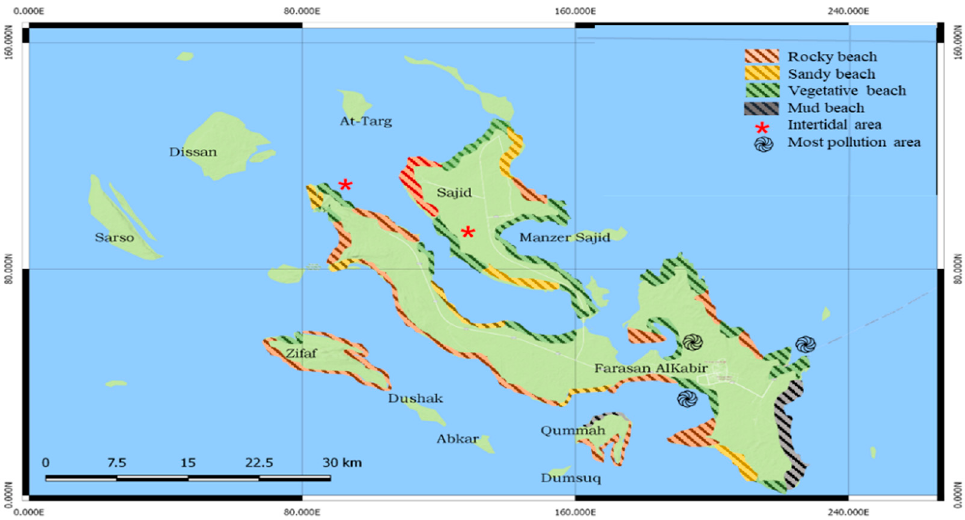
Figure 1. The vegetative beach in the Farasan Archipelago. A spiral shows the most pollution area along the coast zone and asterisks shows the intertidal zone in the Farasan